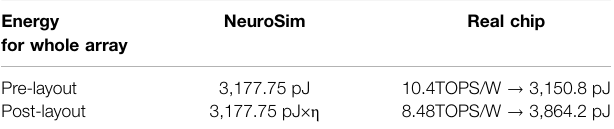
TABLE 6 | Chip-level pre- and post-layout energy